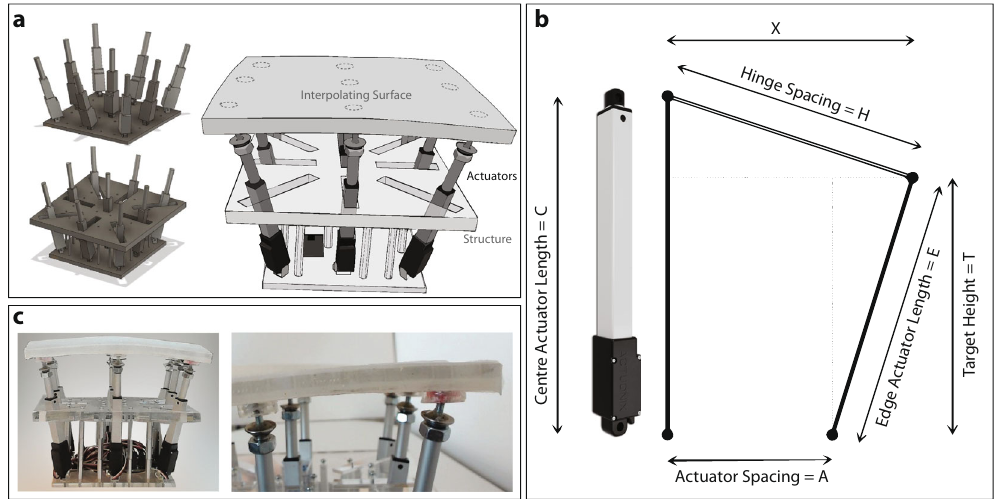
Fig. 3 Building the shape display. a The shape display is composed of 9 actuators mounted in a rigid assembly. The whole surface has mounting points for each actuator. The interpolating surface on the top is made from layers of acrylic and silicone rubber. The acrylic is cut with a pattern that gives it auxetic behavior. b The diagram of the measurements for actuator control. c The prototype ’ s surface is 220 mm square. Actuators are mounted to the interpolating surface with ball